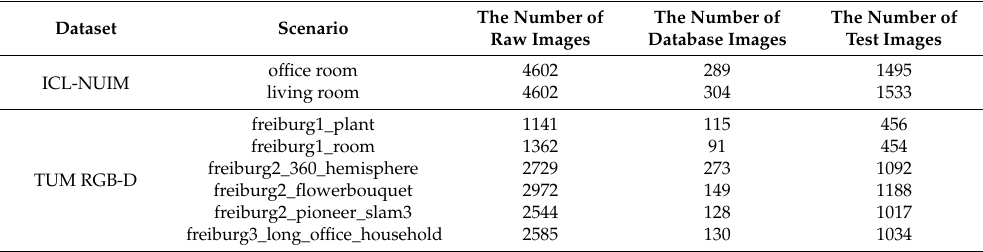
Table 2. We chose images from different scenarios of ICL-NUIM and TUM RGB-D to compose our own experiment dataset.